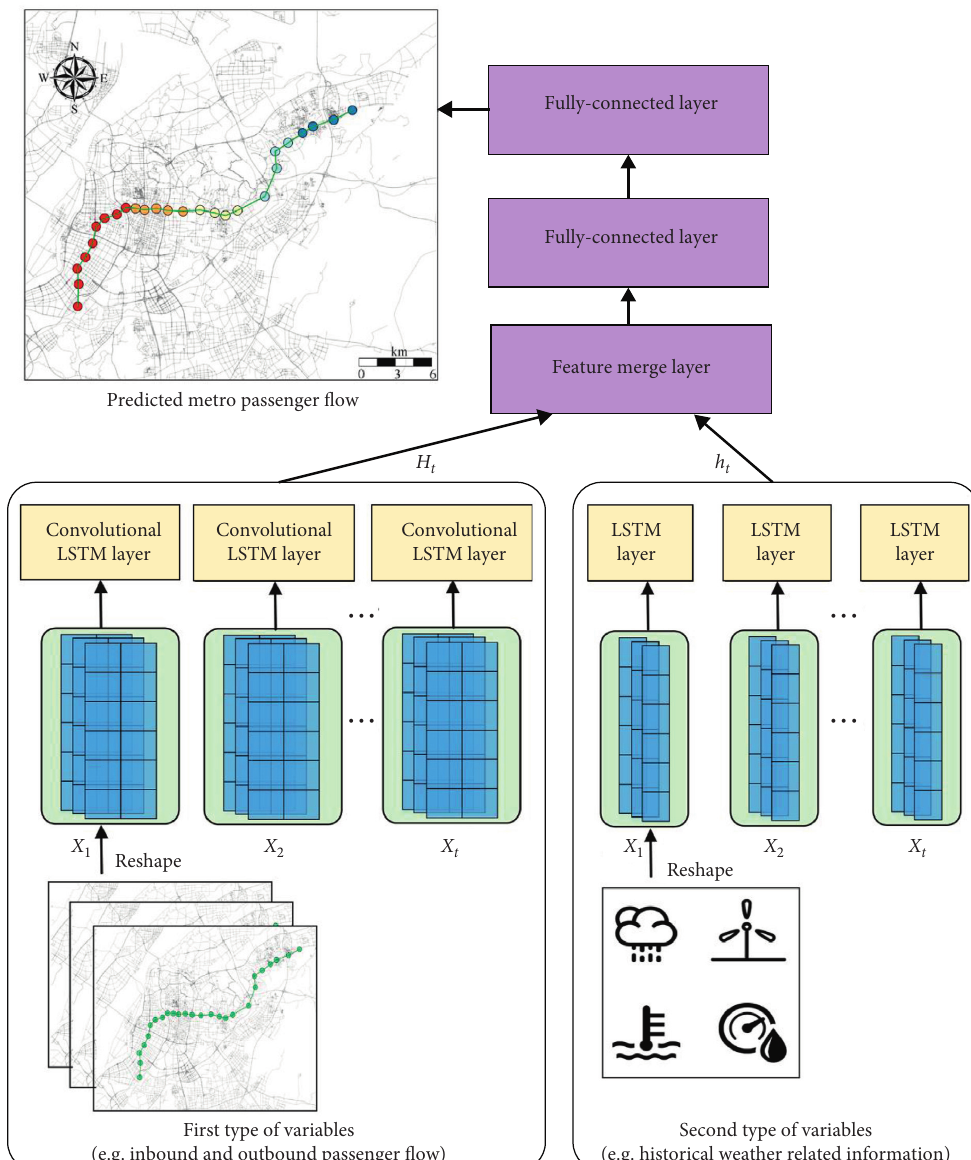
Figure 2: The structure of the proposed